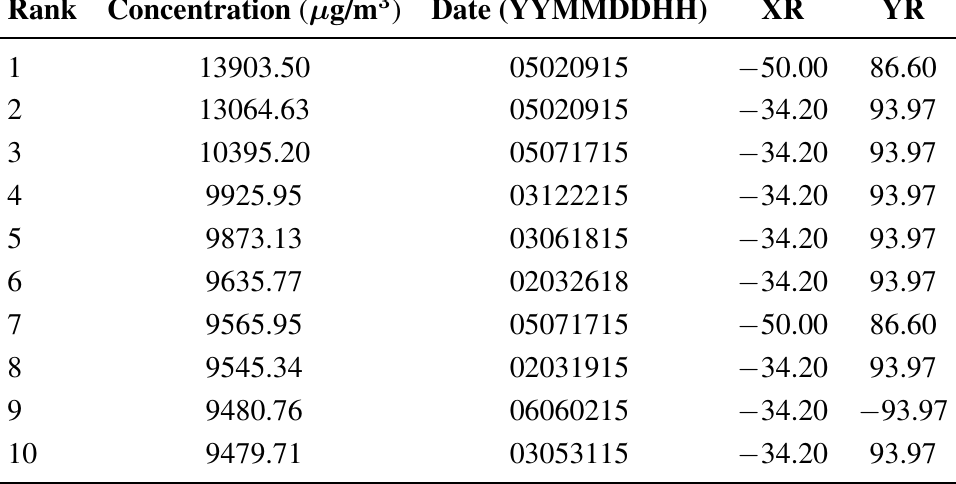
Table 3. Ten highest concentration on 3 h averaging time. XR and YR are the receptor’s